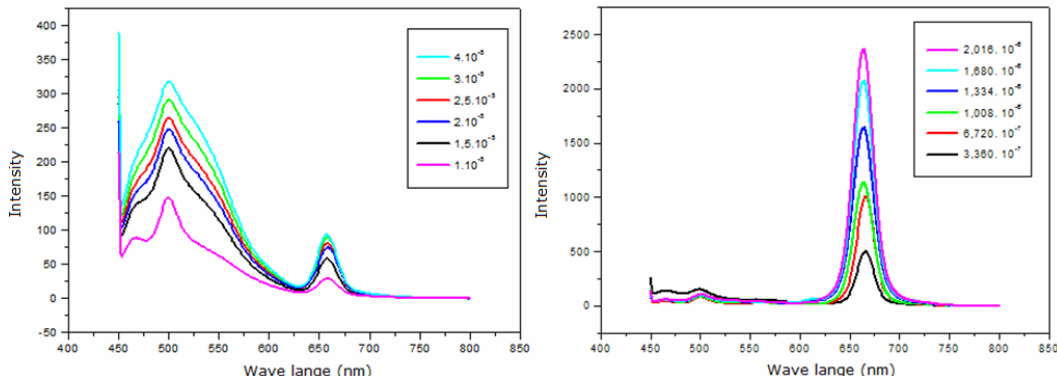
Figure 6. Fluorescence emission spectra of standard chlorin e 6 (right) and Cu(II)chlorin e 4 (left) obtained for six different concentration of sample. Table II. Fluorescence quantum yield (Ф F )